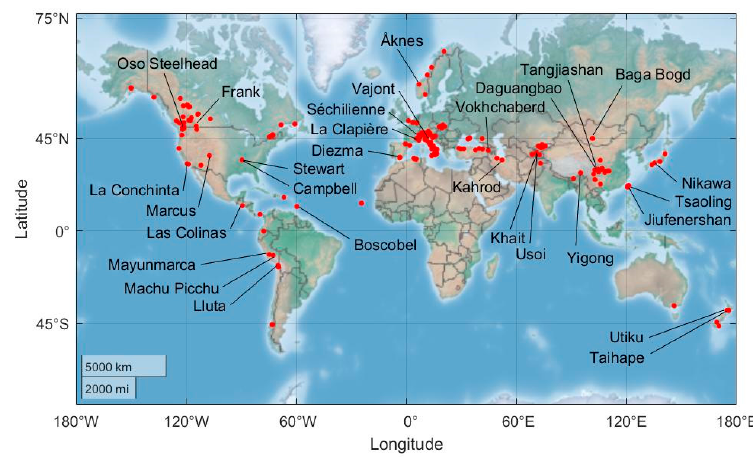
Figure 3. Locations of the 277 landslides included in the database (map from MATLAB [32]).